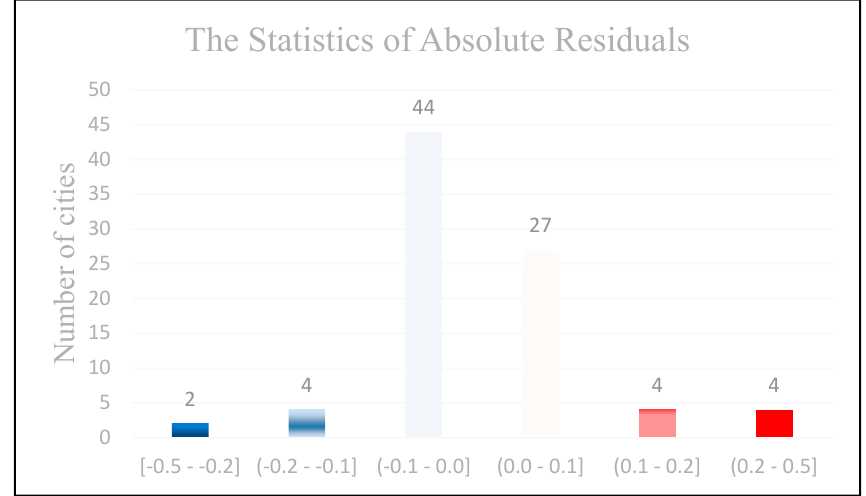
Figure 7. The statistical result of the absolute residuals by using the OSM road network density.